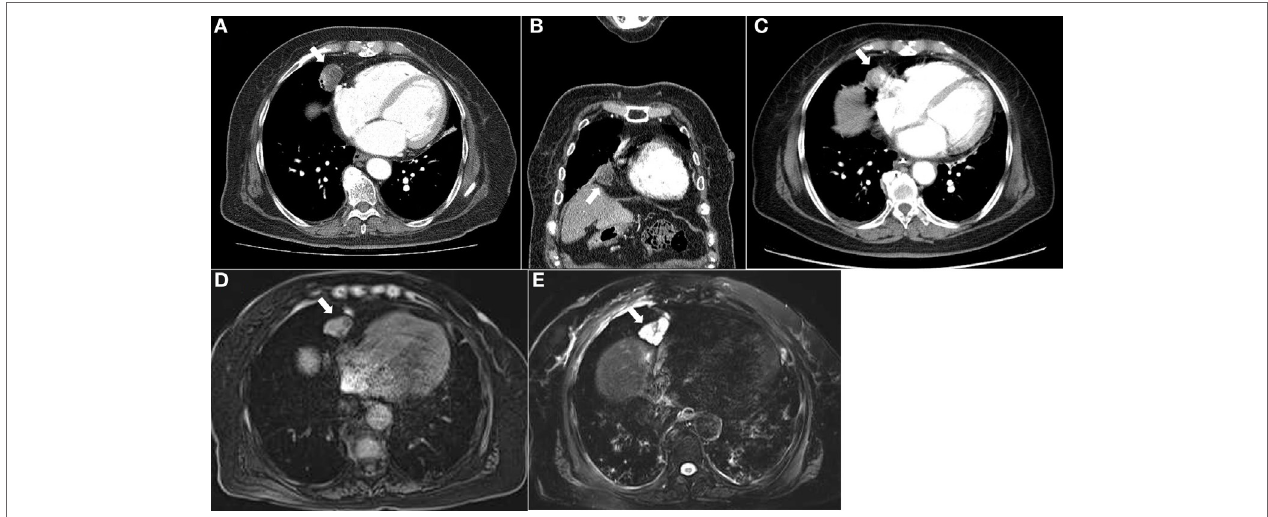
FIgURe 1 | Computed tomography of the chest demonstrated a round-shaped, poorly enhancing mass with cystic portions measuring 2.7 cm at the right anterior cardiophrenic angle in the axial (a) and coronal (b) images. This lesion was observed on an incidenta abdominal CT scan taken 3 years ago. (C) Magnetic resonance imaging of the chest showed a lobulating mass at the right anterior cardiophrenic angle, with intermediate signal intensity on the T1-weighted image (D) and high signal intensity on the T2-weighted image (e)